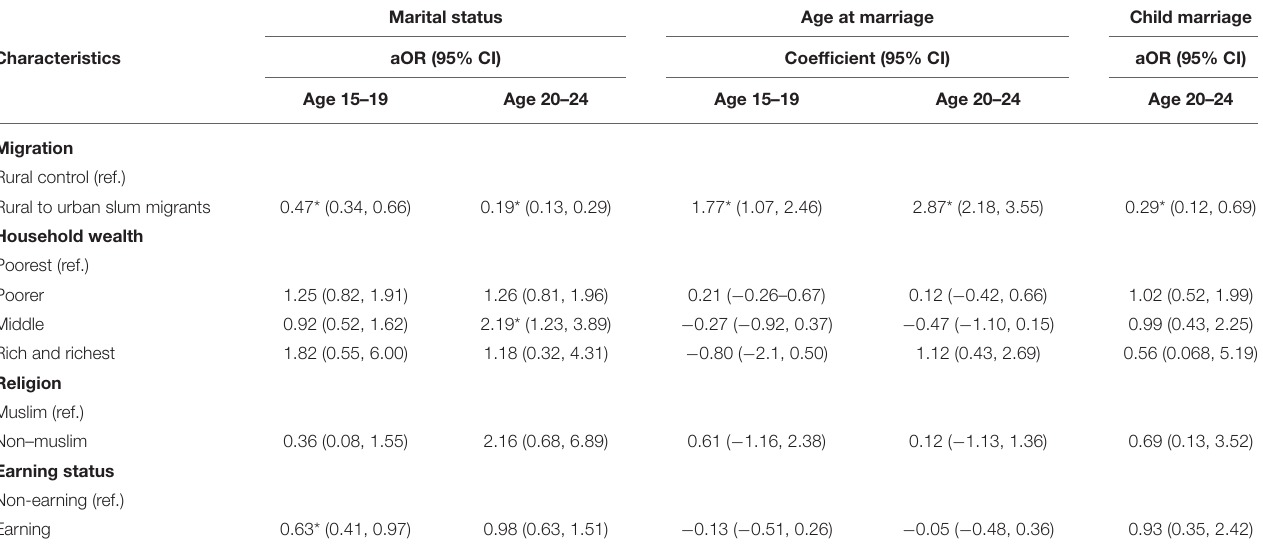
TABLE 2 | Effect of migration on marital status, age at first marriage and child